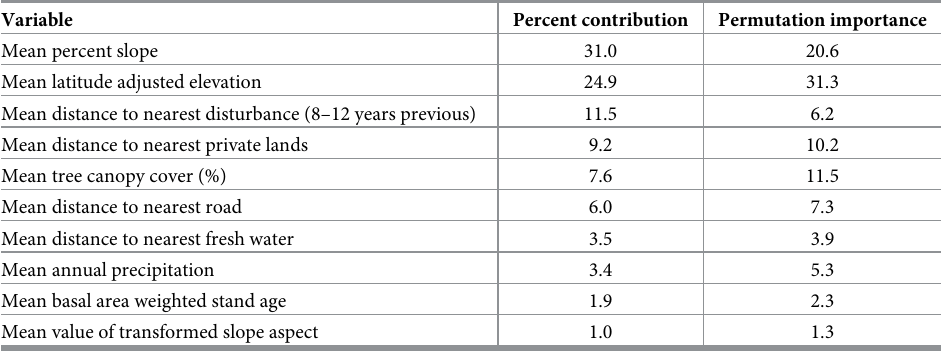
Table 2. Contribution and importance of each predictor variable for the final model estimating relative likelihood of trespass cannabis cultivation in forested areas of California and southern Oregon 2008–2014.